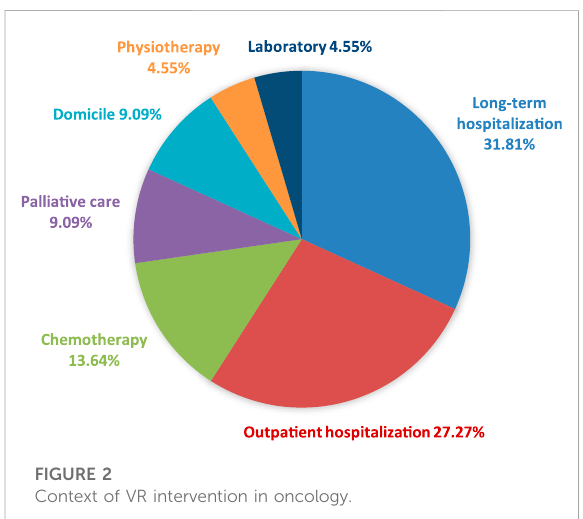
FIGURE 2 Context of VR intervention in